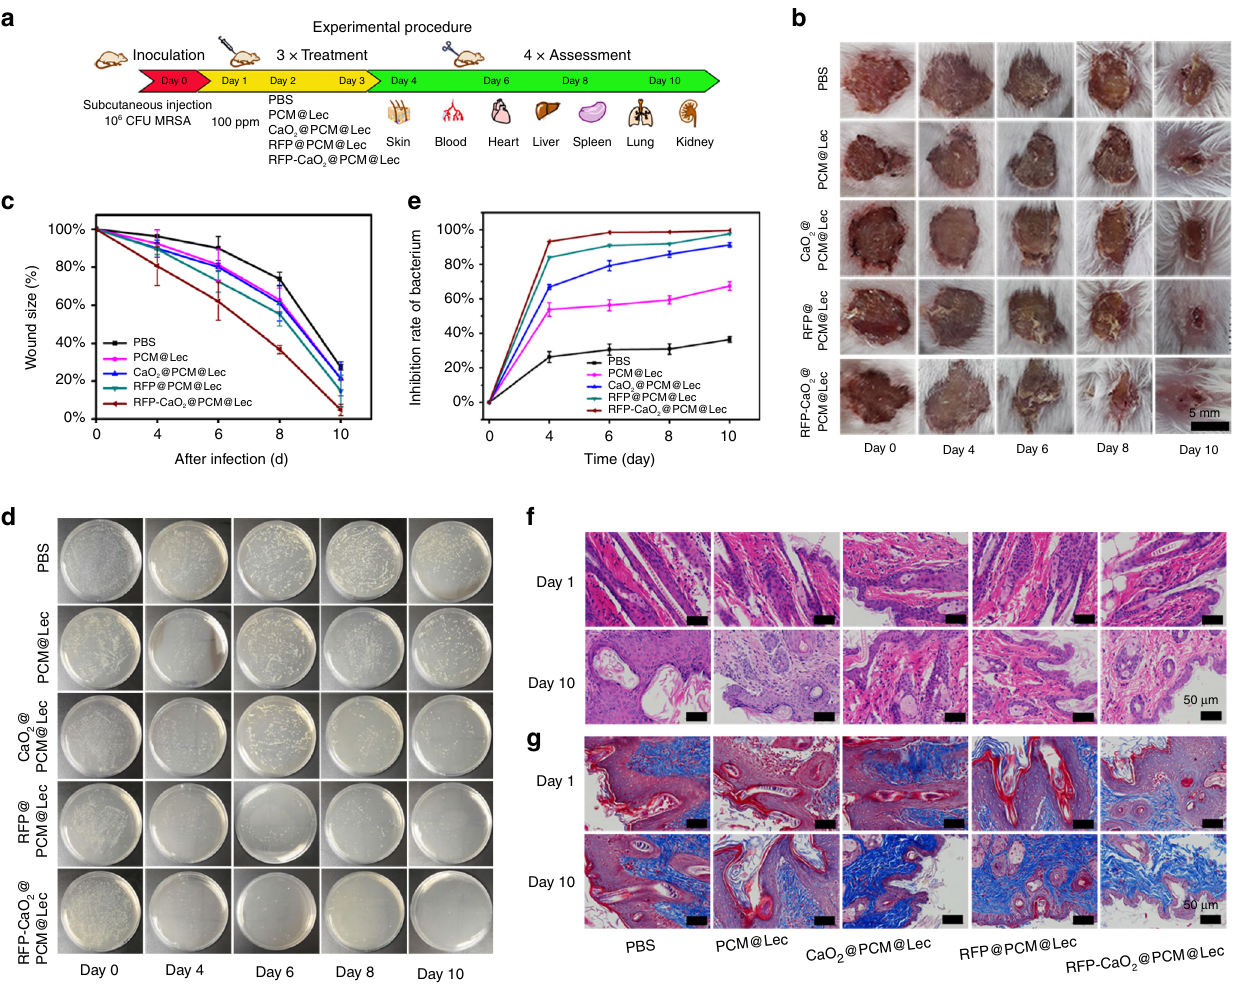
Fig. 5 Evaluation of antibacterial activity in vivo. a The study protocol including MRSA inoculation and infection development on the BALB/c mice (6 – 8 weeks old), followed by the different treatments. b Photographs of wounds infected by MRSA. c Wound size (%) on different days (0, 4, 6, 8, 10). d The grown colonies and e the inhibitory ef fi ciency (relative number of bacteria vs. initial number of bacteria) of wound. f H&E and g Masson images of the wounds on the fi rst day and tenth day. Error bars = standard deviation ( n = 3), Source data are provided as a Source Data fi